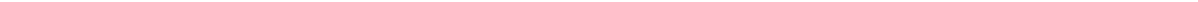
Fig. 6 Arhgef6 − / − MZB migrate faster, detach more under fl ow, and respond strongly to S1P. a Representative track plots of wild-type (WT) and Arhgef6 − / − MZB bells, untreated or with S1P (200 nM), migrating under fl ow (3 dyn cm − 2 ) on ICAM-1 (2.5 µ g ml − 1 ) or VCAM-1 (2.5 µ g ml − 1 ). b Quanti fi cation of migration index, velocity, straightness, and percentage of cells that migrated > 10 µ m for WT (gray bars) and Arhgef6 − / − (white bars) MZB on ICAM-1 or VCAM-1 (WT: n = 4 mice, Arhgef6 − / − : n = 5 mice; 5 experiments total). Data are expressed as mean ± SEM. * P < 0.05, ** P < 0.01, *** P < 0.001, by t test (for migration index and % displacement on ICAM-1), one-way ANOVA (for straightness and % displacement, comparison of values to WT), and two-way ANOVA (velocity on ICAM-1, migration index on VCAM-1). c Detachment of WT and Arhgef6 − / − MZB. Fraction of remaining cells calculated as a % relative to number of cells after start of fl ow on ICAM-1 (1.5 µ g ml − 1 ), VCAM-1 (1.5 µ g ml − 1 ), or ICAM-1 and VCAM-1 together (0.75 µ g ml − 1 each) under fl ows of 3 dyn cm − 2 (0 – 10 min), 9 dyn cm − 2 (10 – 20 min), and 15 dyn cm − 2 (20 – 30 min) ( n = 5 mice per genotype, 5 experiments total). d Static adhesion of WT and Arhgef6 − / − MZB treated with S1P (200 nM) on ICAM-1 (2.5 µ g ml − 1 ), relative to total adhesion on poly-lysine. Bars are mean plus SEM. ** P < 0.01, two-way ANOVA for S1P treatment difference. Data are from three experiments with two mice (one per genotype) each. ns not signi fi